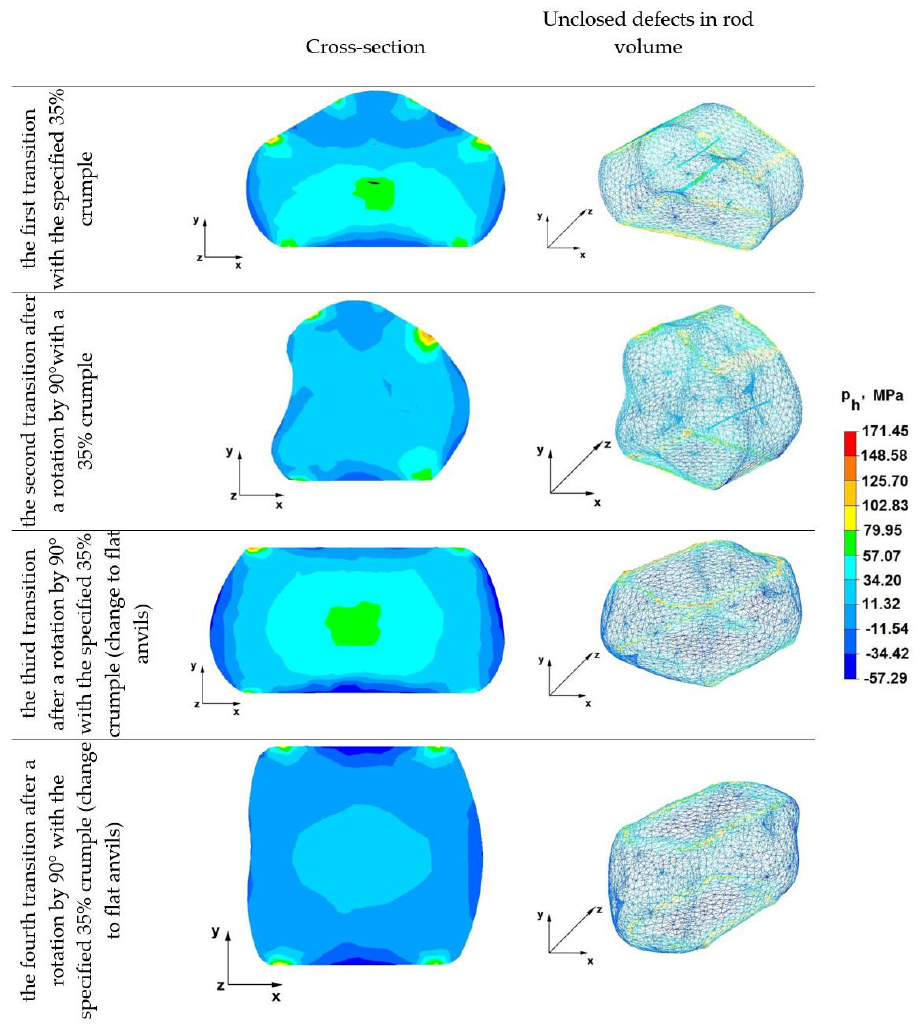
Figure 9. Hydrostatic pressure distribution in rhombic flat anvils.